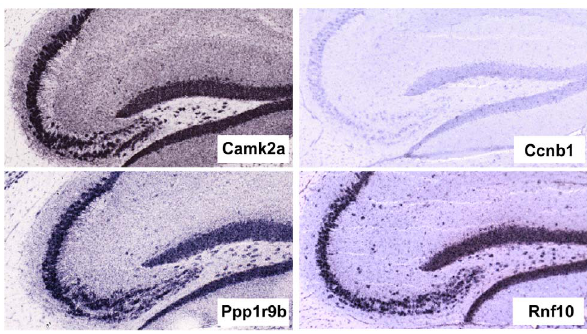
Figure 4. In situ hybridization pattern of the indicated protein- coding genes, obtained from the Allen Brain Atlas. Camk2a was included as a positive control while Ccnb1, which encodes for transcripts expressed only in mitotic cells, was included as a negative control to give an idea of background signal levels.